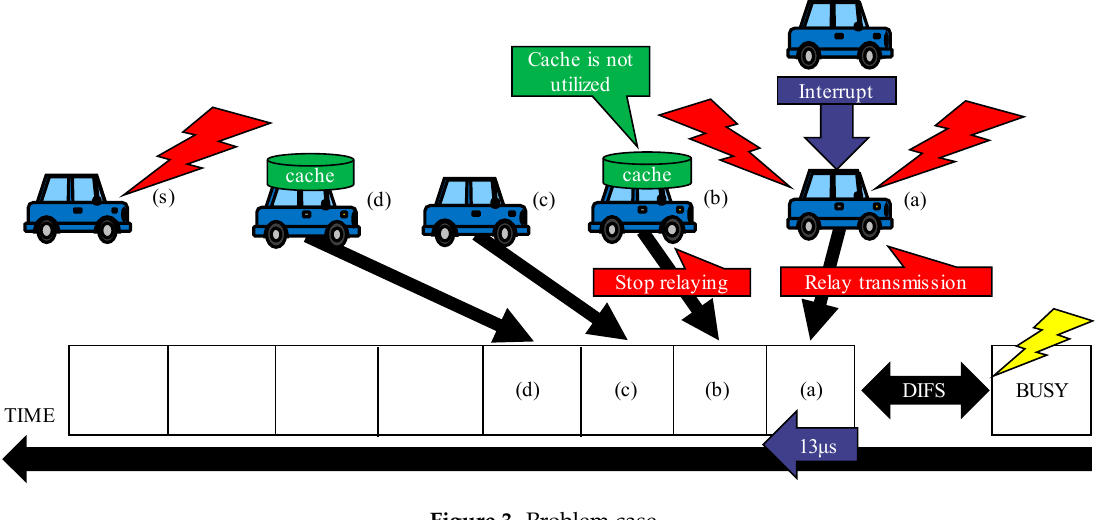
Figure 3. Problem case.